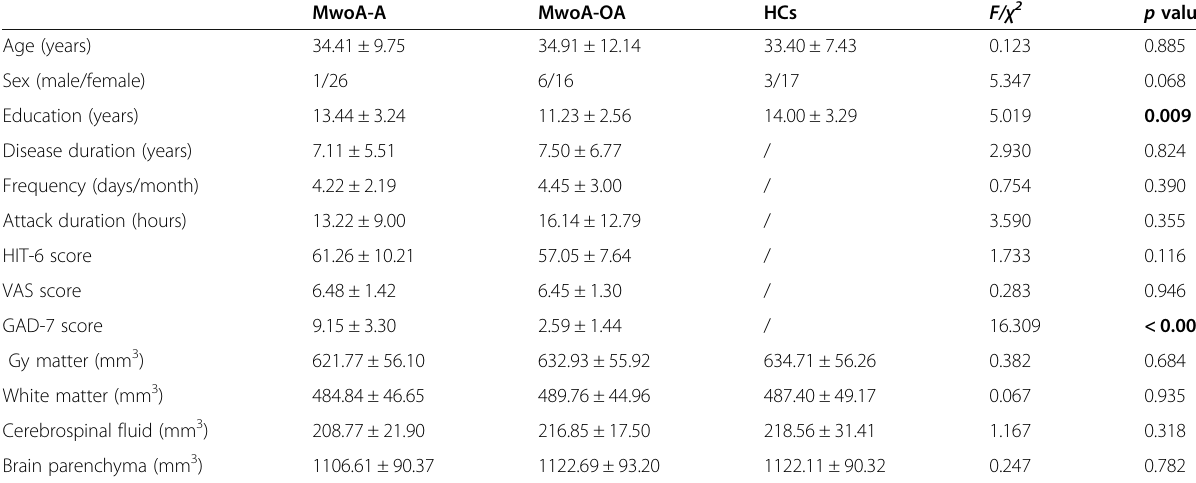
Table 1 Demographic and clinical variables of all